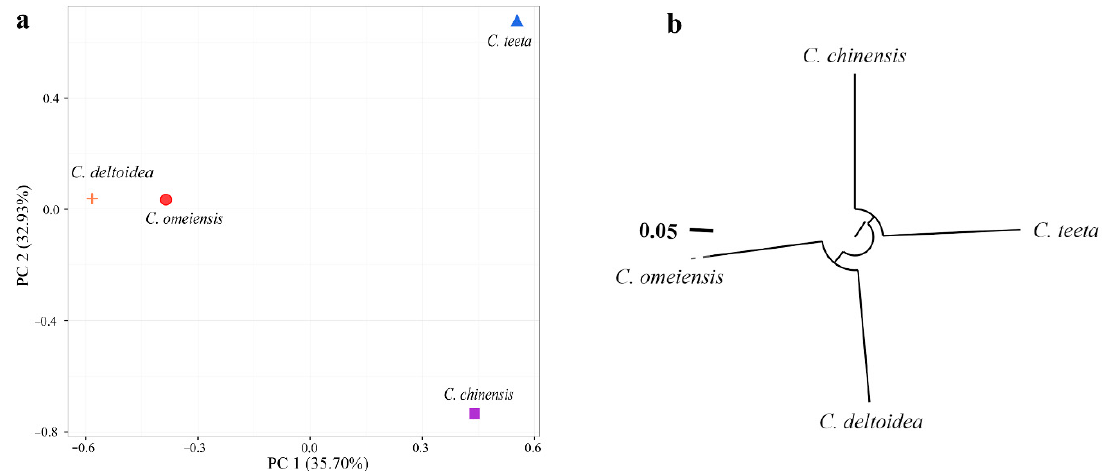
Figure 6. ( a ) Principal component analysis of the four Coptis plants based on identified SNPs; ( b ) Neighbor-joining tree based on identified SNPs.